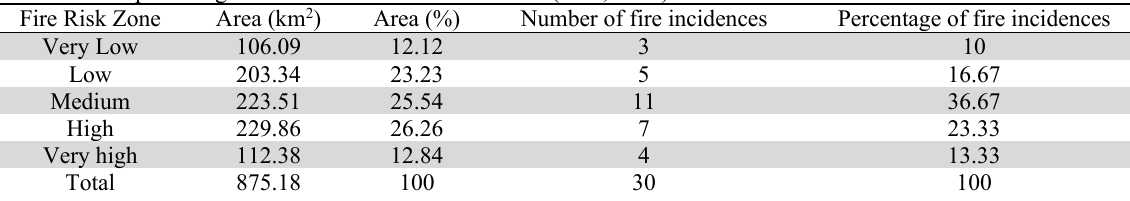
Fire risk zones percentage with number of fire occurrences (PSD,